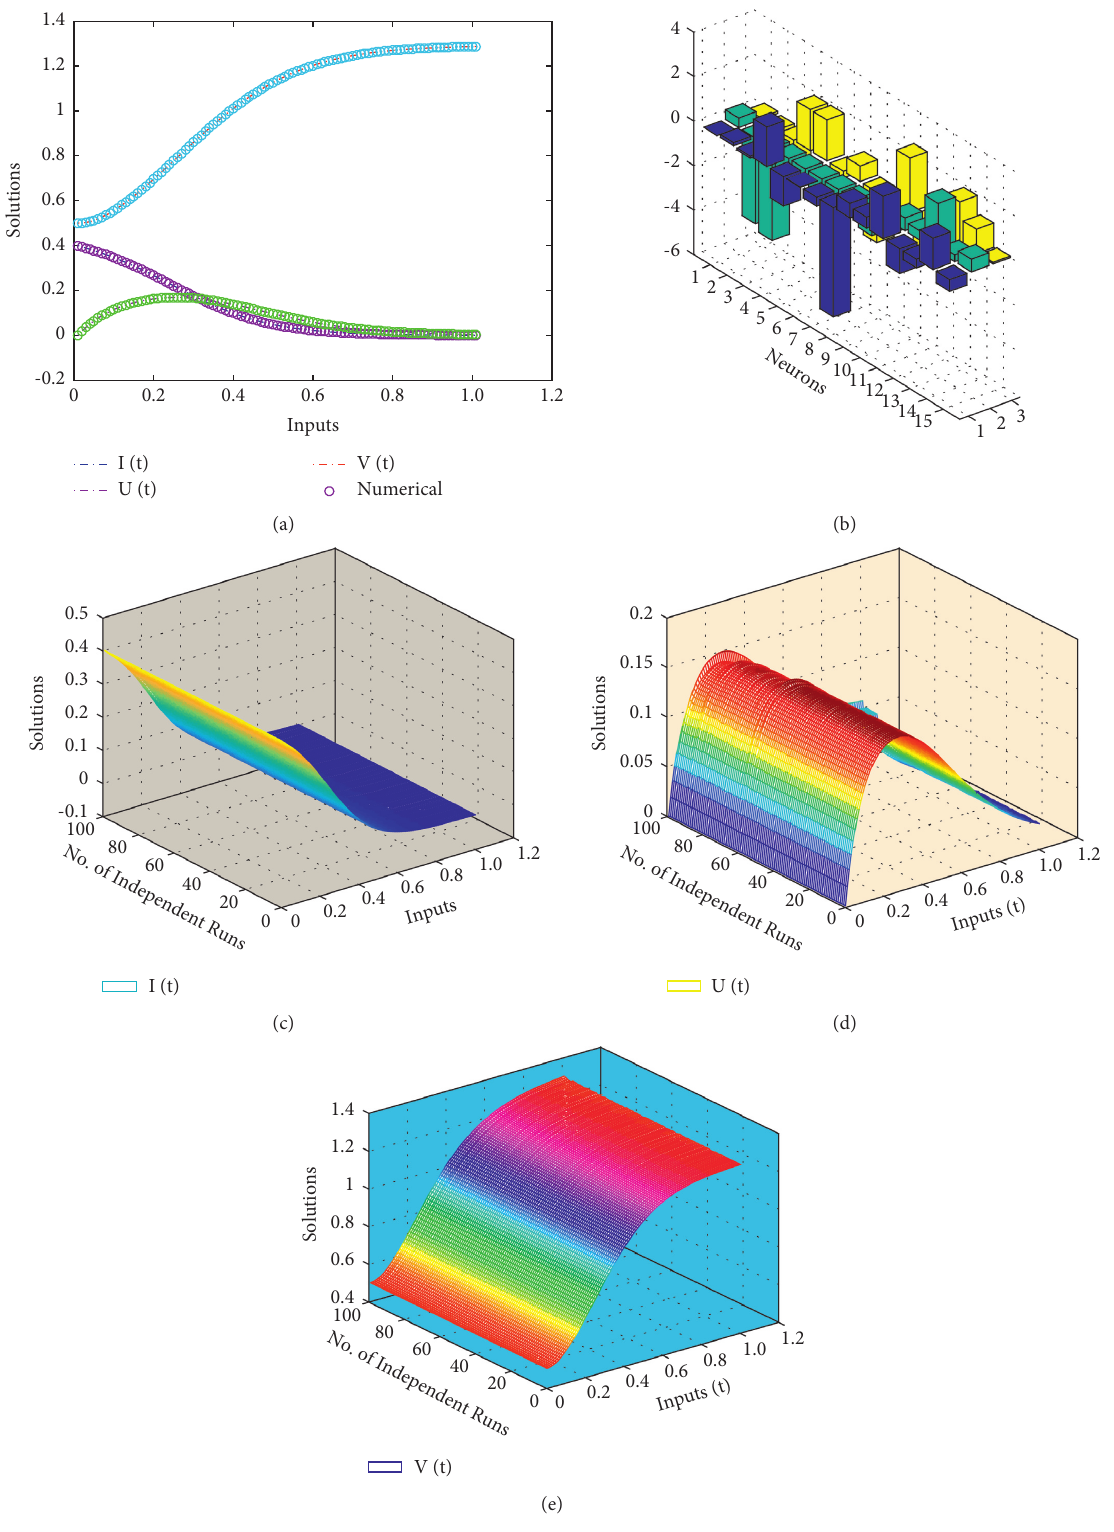
Figure 6: Problem 4: graphical evaluation for tumor growth ratio ( r ) to rate of cell lysis ( δ ) f � 0 . 36, the inverse of burst size parameter g � 0 . 02, and the viral decay ( α ) ratio to rate of cell lysis ( δ ) h � 0. (a) Solution f � 0.36, g � 0.02, and h � 0 with initial conditions I (0) � 0.4, U (0) � 0, and V (0) � 0.5, (b) weights obtained by ANN-SCA-SQP for CVRT, (c) solutions of 100 independent runs of I ( t ), (d) solutions of 100 independent runs of U ( t ), and (e) solutions of 100 independent runs of V ( t